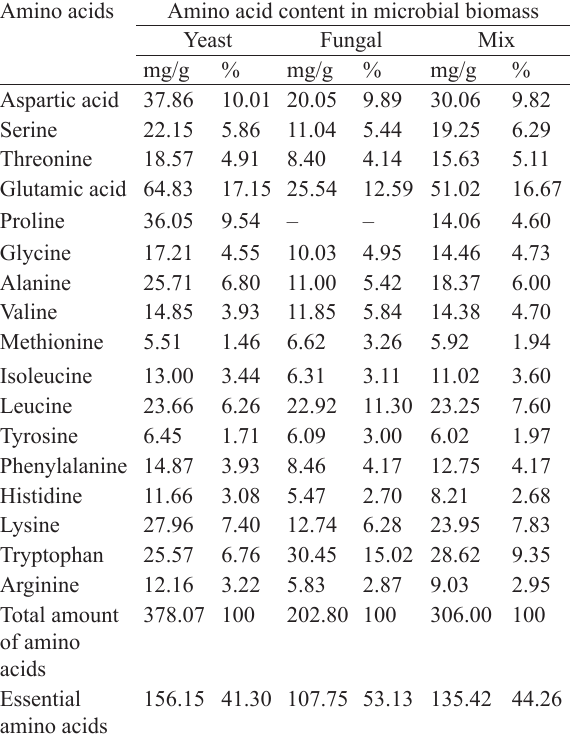
Table 1 Amino acids in the microbial biomass mix ( Aspergillus oryzae and Sаcharomyces cerevisiae ) Amino acids Amino acid content in microbial biomass